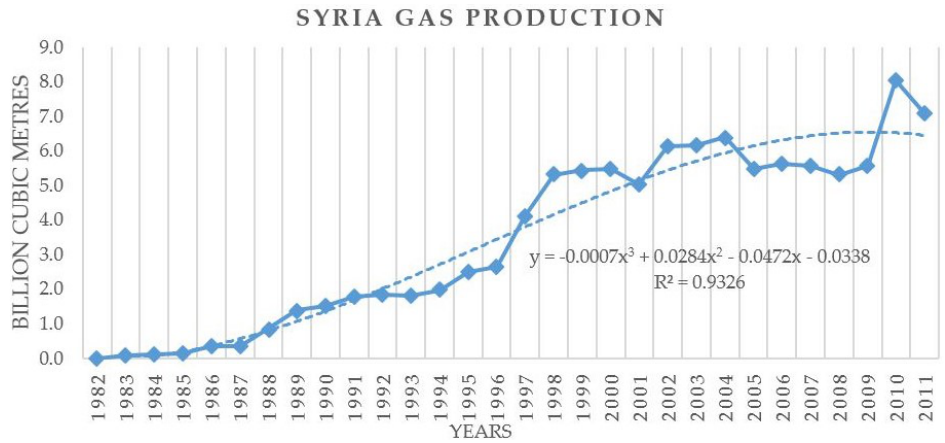
Figure 4. Syria’s gas production (1982–2011) based on data of the BP Statistical Review of World Energy